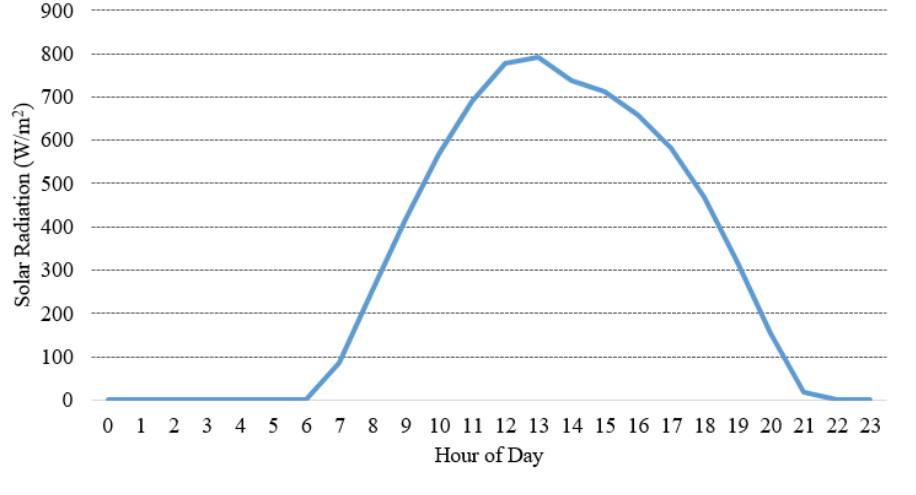
Figure 2. Hourly solar radiation. Table 2. Solar PV panel